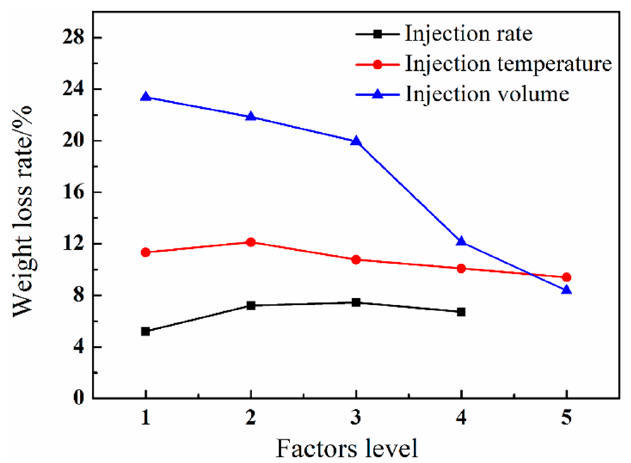
/ PA foams at di ff erent factor